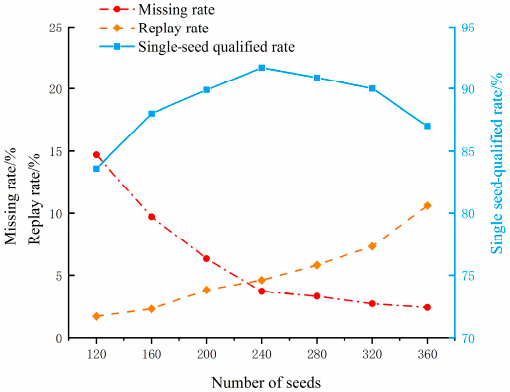
Figure 8. Relationship with evaluation indicators under different population numbers.